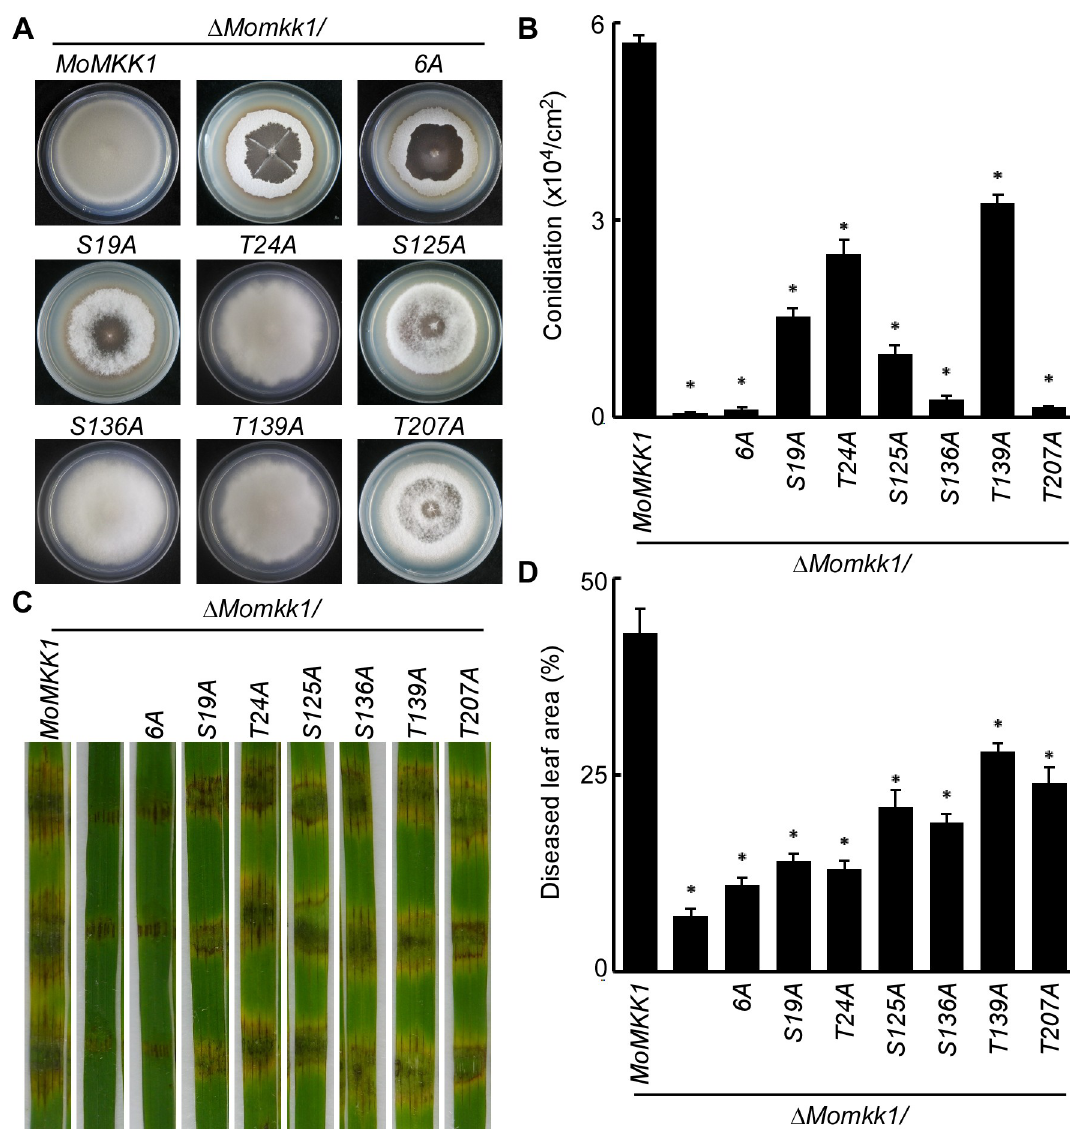
Fig 9. Disruption of MoSep1-dependent MoMkk1 phosphorylation leads to hyphal autolysis, reduced conidiation, and attenuated virulence. (A) Autolysis observation of Δ Momkk1/MoMKK1 , Δ Momkk1 , Δ Momkk1/MoMKK1 6A ( Δ Momkk1/ MoMKK1 S19A , T24A , S125A , S136A , T139A , T207A ), Δ Momkk1/MoMKK1 S19A , Δ Momkk1/MoMKK1 T24A , Δ Momkk1/MoMKK1 S125A , Δ Momkk1/MoMKK1 S136A , Δ Momkk1/MoMKK1 T139A , Δ Momkk1/MoMKK1 T207A mutant strains on CM medium. Hyphae autolysis is a process of self-digestion of hyphal cultures. The part of the aerial hyphae with autolysis appeared watery collapse. (B) Statistical analysis of conidia production on SDC medium cultured at 28˚C for 7 days in the dark followed by 3 days of continuous illumination under fluorescent light. Error bars represent the standard deviations from three independent experiments. Asterisks indicate statistical significance according to a Student’s test (p < 0.01). (C) Pathogenicity test on rice leaves. Wounded rice leaves were incubated with different strains. Diseased leaves were photographed 4 days after inoculation. (D) Diseased leaf area analysis of (C). Data were presented as a bar chart showing the percentage of lesion areas. Error bars represent the standard deviations from three independent experiments. Asterisks indicate statistical significance according to a Student’s test (p < 0.01). the Δ Mosep1 / MoMKK1 6D and Δ Momkk1/MoMKK1 6A strains. When stained with CFW, addi- tional septa were observed in the Δ Mosep1/MoMKK1 6D strain than in Δ Mosep1 mutant and fewer septa in the Δ Momkk1/MoMKK1 6A strain than Guy11 (Fig 10A–10C), suggesting that the activation of the MoSep1-dependent phosphorylation sites is important for the formation